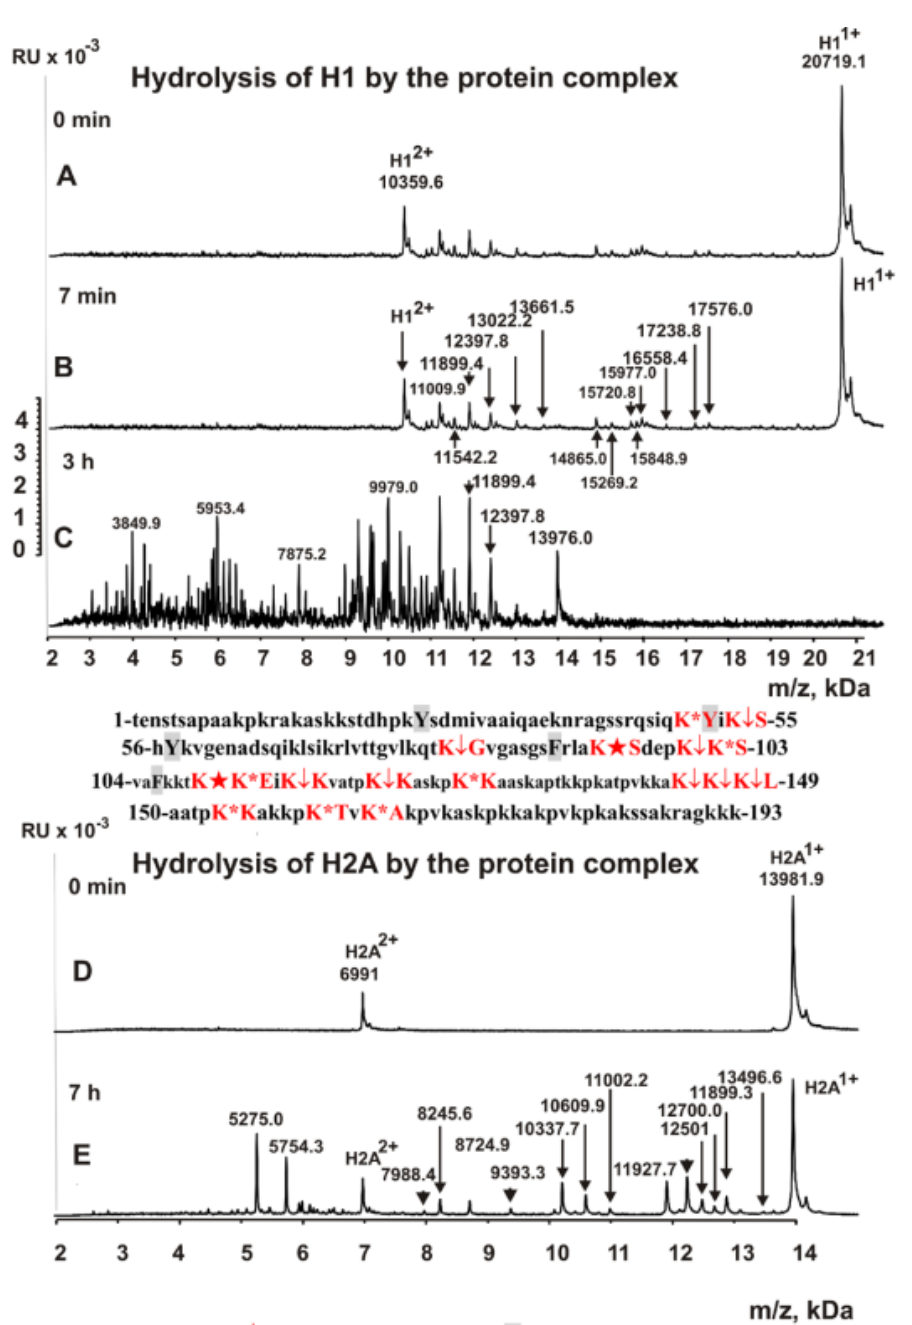
Figure 2. MALDI spectra correspond to 0.8 mg/mL H1 ( A – C ) and H2A histone ( D , E ) in the presence of sea cucumber stable complex (0.15 mg/mL or 7.5 × 10 − 8 M). Below the spectra, the protein sequences of histones H1 and H2A and the sites of their hydrolyses by the stable complex are shown. Major cleavage sites are indicated by large stars ( ★ ), moderate sites by arrows ( ↓ ), and minor sites by colons (:) ( A – D ). Aromatic residues of the protein sequence are marked in grey, after which no histone hydrolysis is observed. RU: relative values.